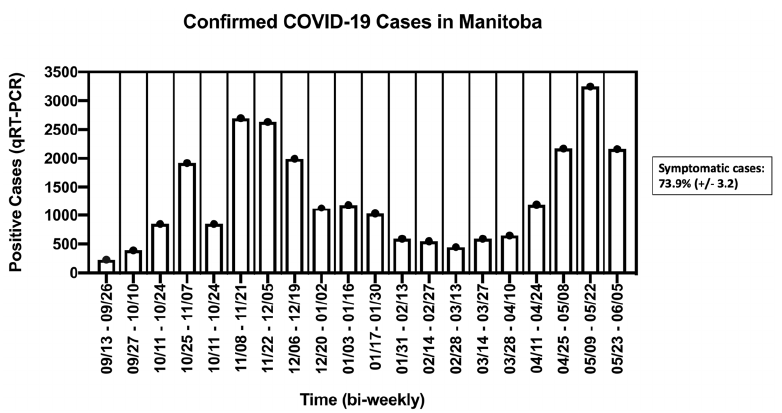
Figure 1. Epidemiological data of qRT-PCR positive cases in Manitoba from 13 September 2020 to 5 June 2021. Data were compiled from Manitoba’s Provincial COVID-19 Surveillance System (https://www.gov.mb.ca/health/publichealth/surveillance/covid-19/index.html. Accessed on 30 No- vember 2021) presented as a rolling average of two-week case counts. Every two-week interval in- cluded in the analysis reported the percentage of individuals that were symptomatic at the time of testing (73.9% (±3.2)). An overall average was calculated from each two-week interval.